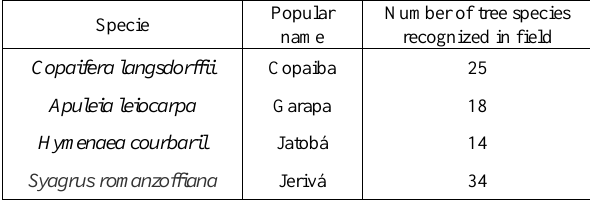
Table 2. Tree species classified and their number of samples recognized in field